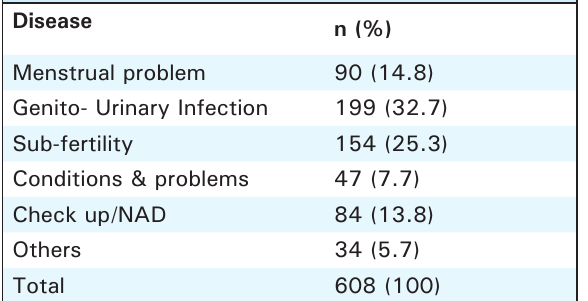
Table 2. Health problems among women in 2017.